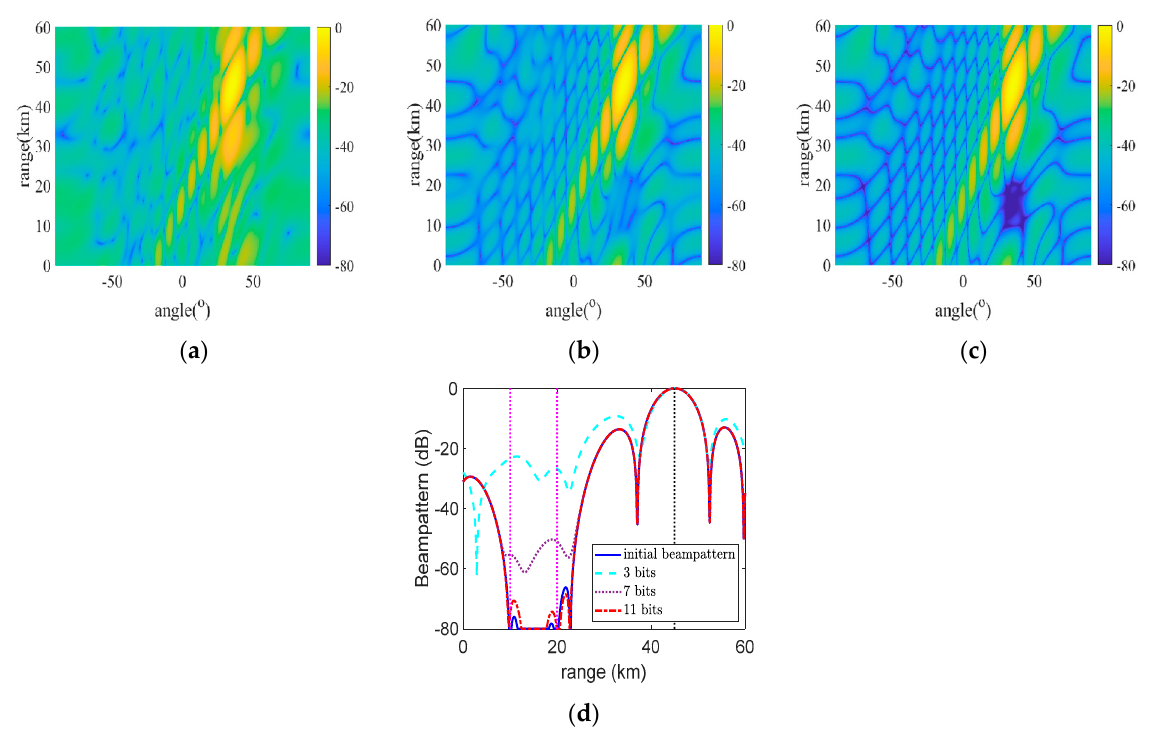
Figure 10. The CMD beampattern on different quantization bits: ( a ) 3 bits, ( b ) 7 bits, ( c ) 11 bits, ( d ) cross–section of different quantization at target angle.